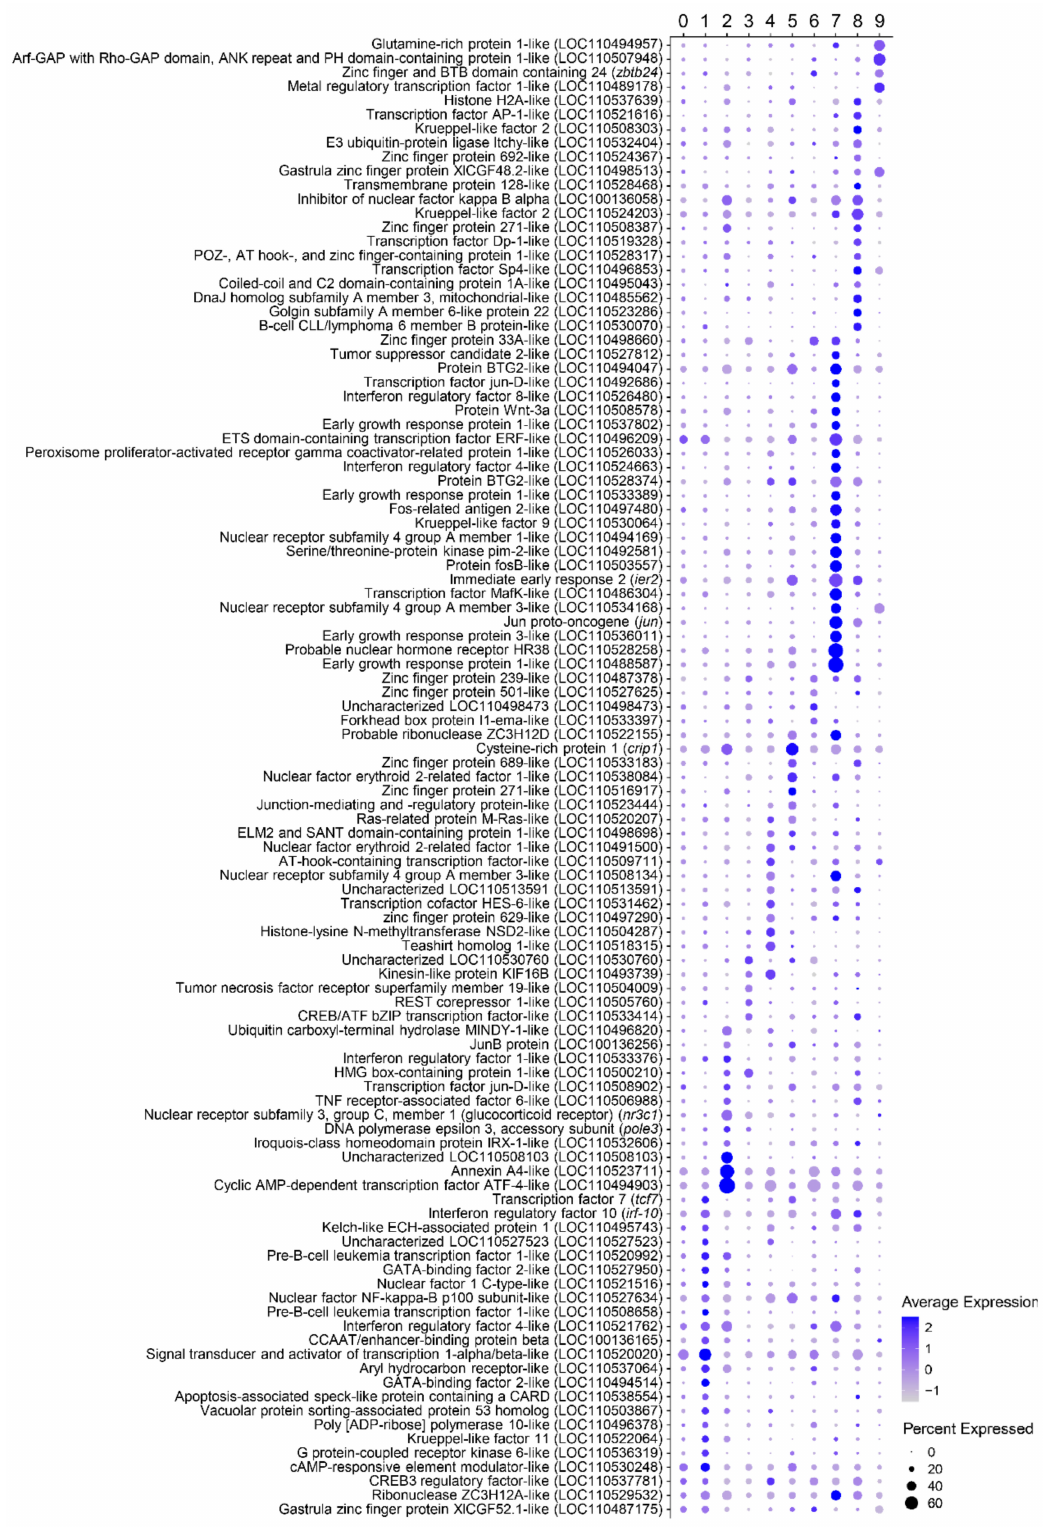
Figure 5. Dot plot analysis including those marker transcripts identified for each cell cluster related to the activity of transcription factors. For each gene, the average normalized expression (dot color) together with the percentage of cells expressing the gene (dot size) are shown for each